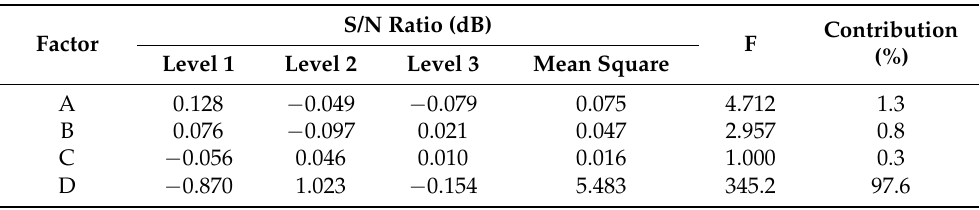
Table 6. Signal-to-noise ratio and ANOVA for multiobjective optimization.